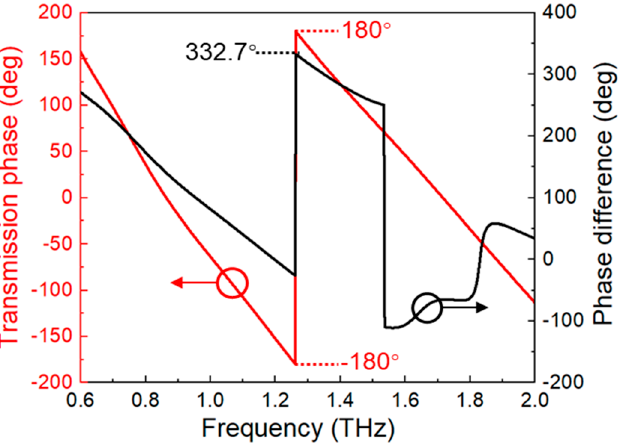
Figure 3. The transmission phase (red curve) and phase difference (black curve) of the metasurface.